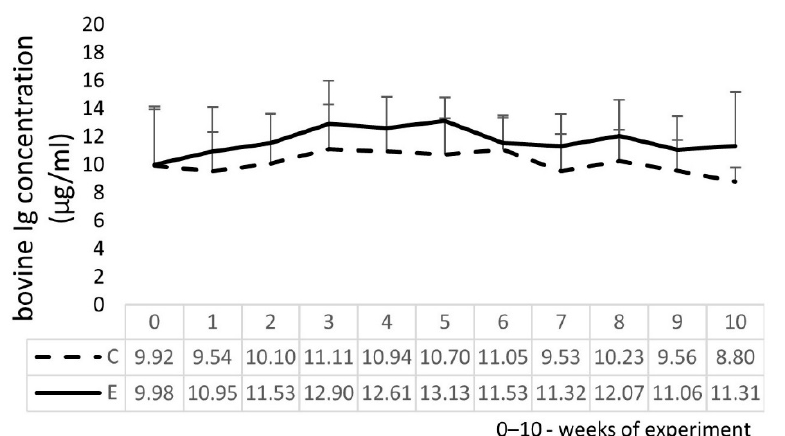
Figure 3. Bovine immunoglobulin (Ig) concentration in the serum of experimental (E) and control (C) calves.